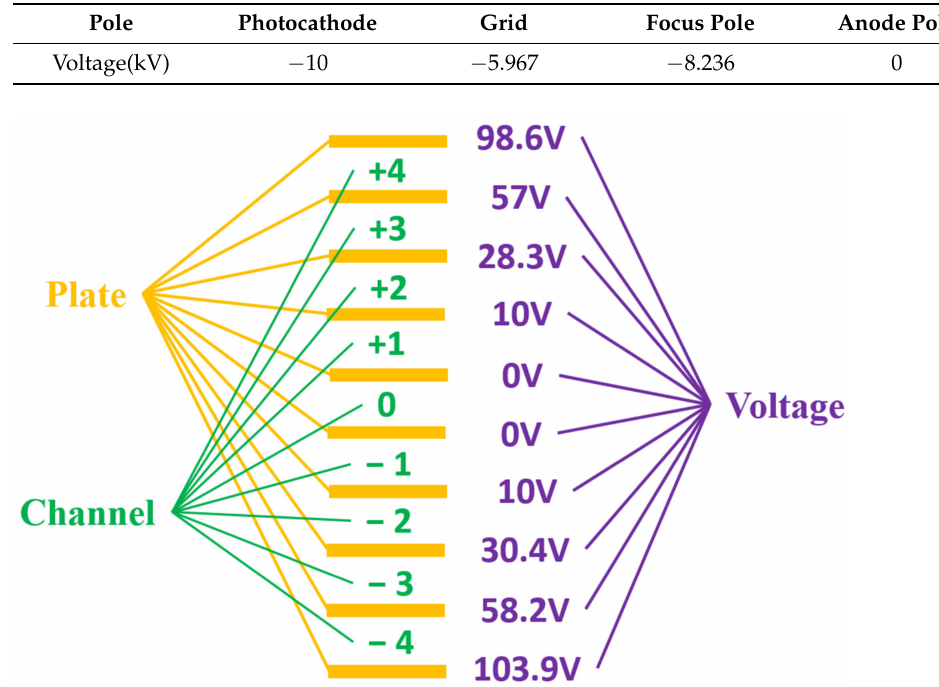
Table 2. Voltage of each electrode in streak tube experiment.